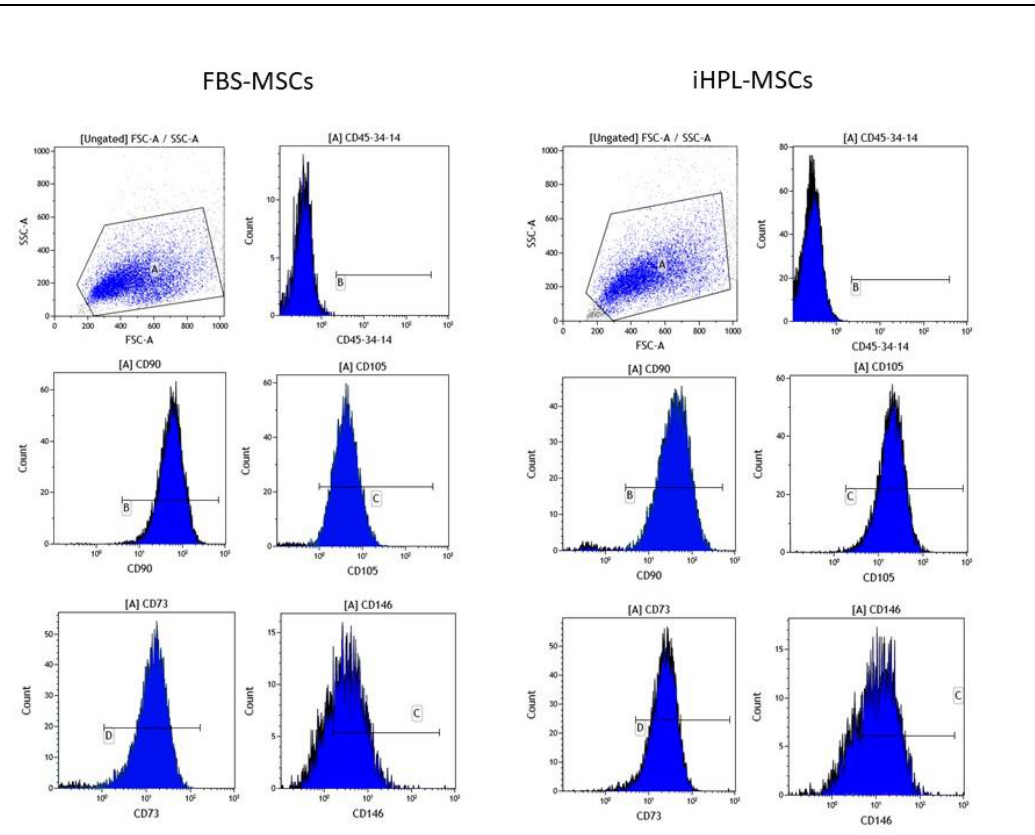
Figure 1. Immunophenotype of a representative cytofluorimetric analysis of fetal bovine serum mesenchymal stromal cells (FBS-MSCs) and inactivated human platelet lysate (iHPL)-MSCs cultures post thawing.